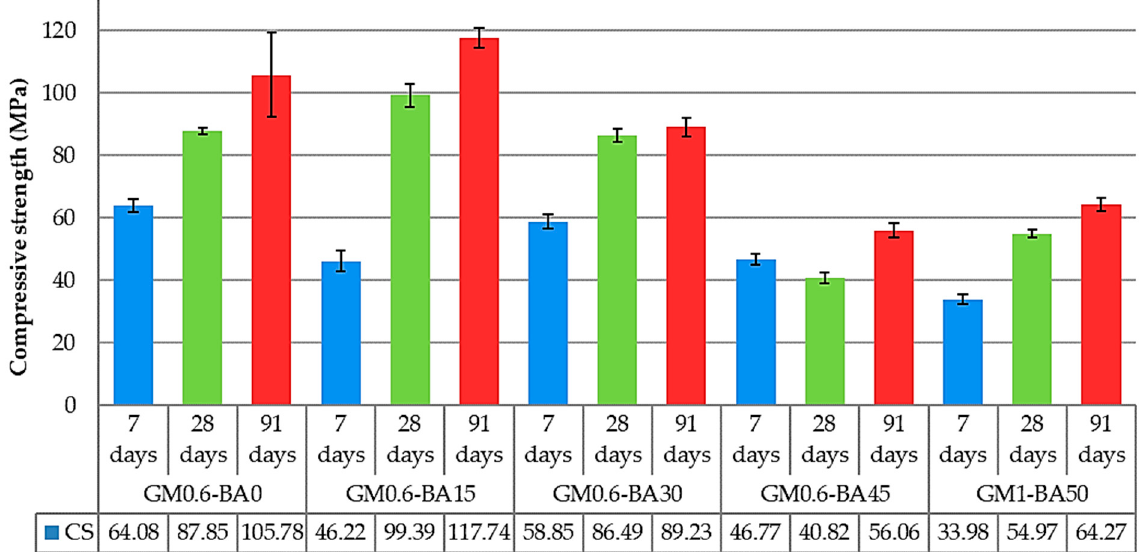
Figure 4. Compressive strength of samples of 7, 28 and 91 days of curing (MPa).